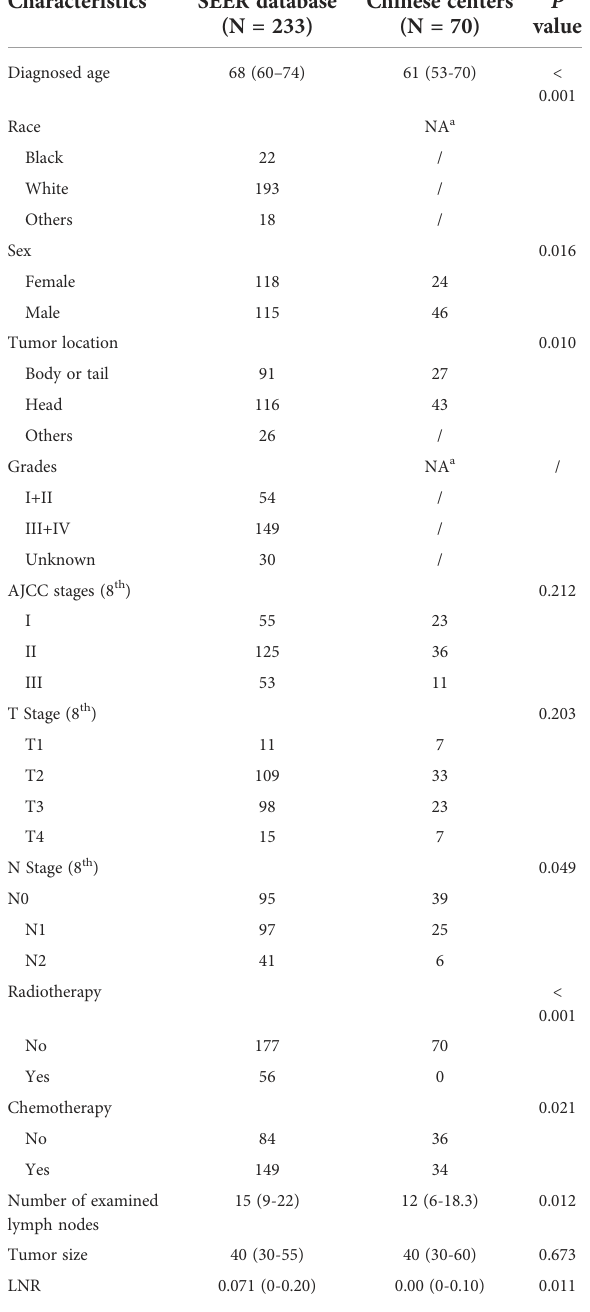
TABLE 1 The clinical characteristics of the ASCP patients from SEER and a multi-center